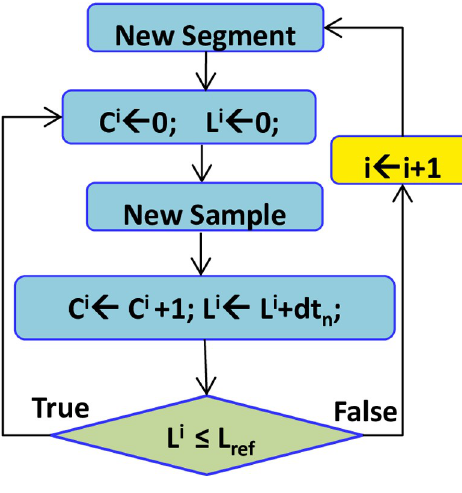
Fig 2. Flow chart of the